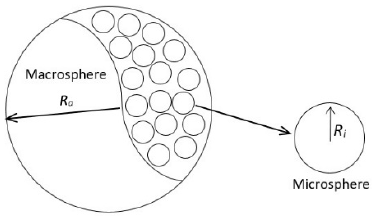
Figure 1. Schematic representation of the coal matrix with micro- and macropores present as assumed by the bidisperse model [43].